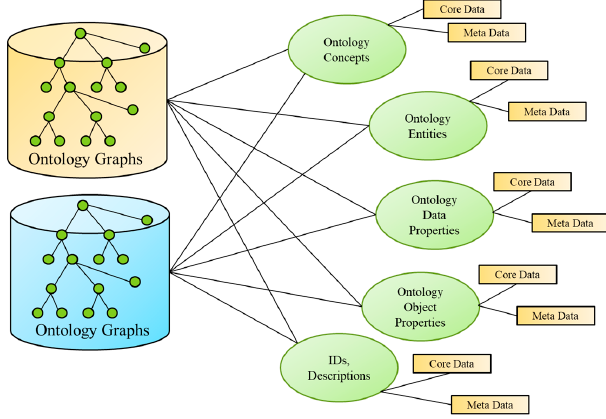
Figure 8. Ontology graphs data descriptions.